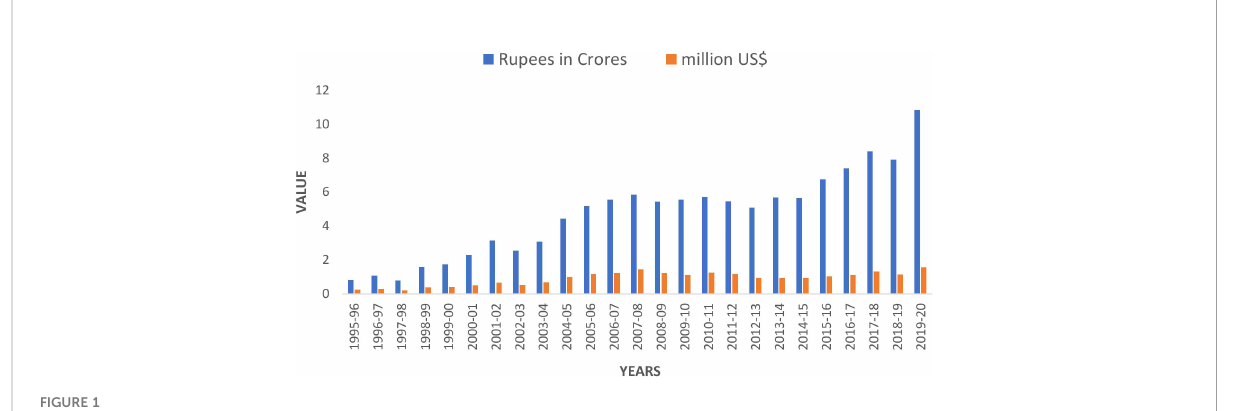
FIGURE 1 Value and trend of ornamental fi sh export from India.